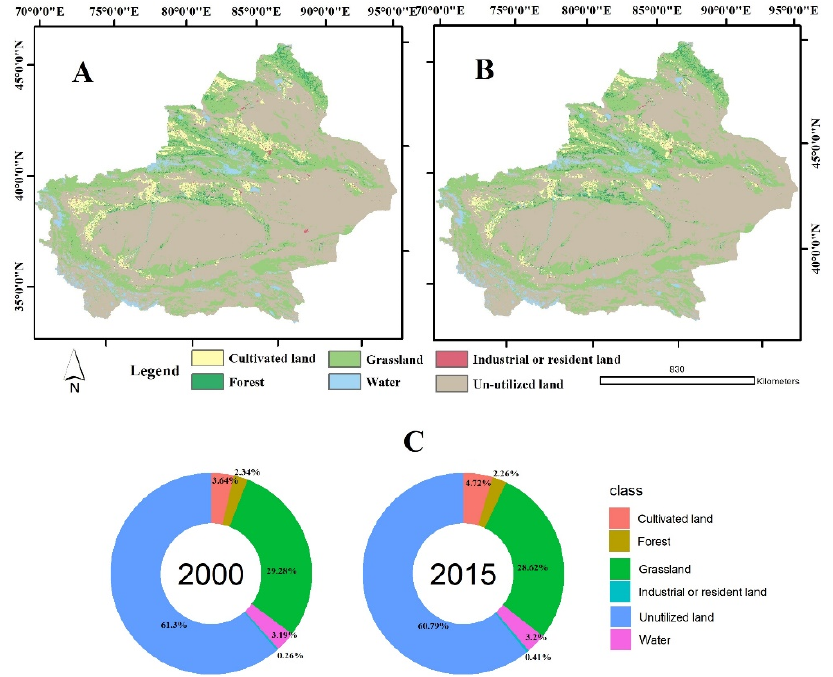
Figure A1. The LULC of Xinjiang in 2000 ( A ) and 2015 ( B , C ) Pie chart showing the percentage of land type.